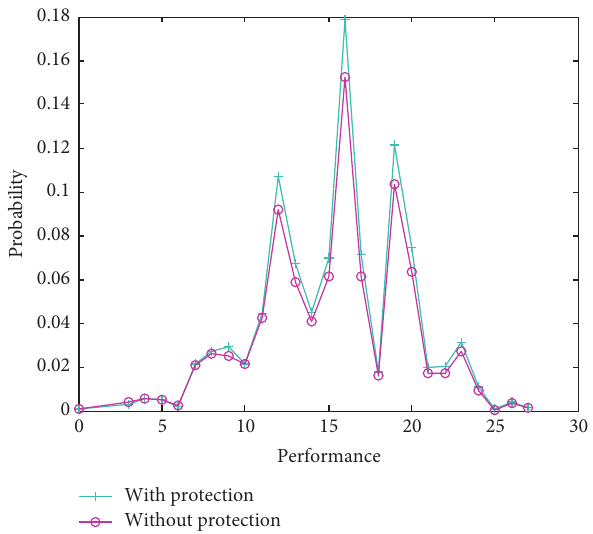
Figure 7: Comparison of items in the UGF under system with and without protection.